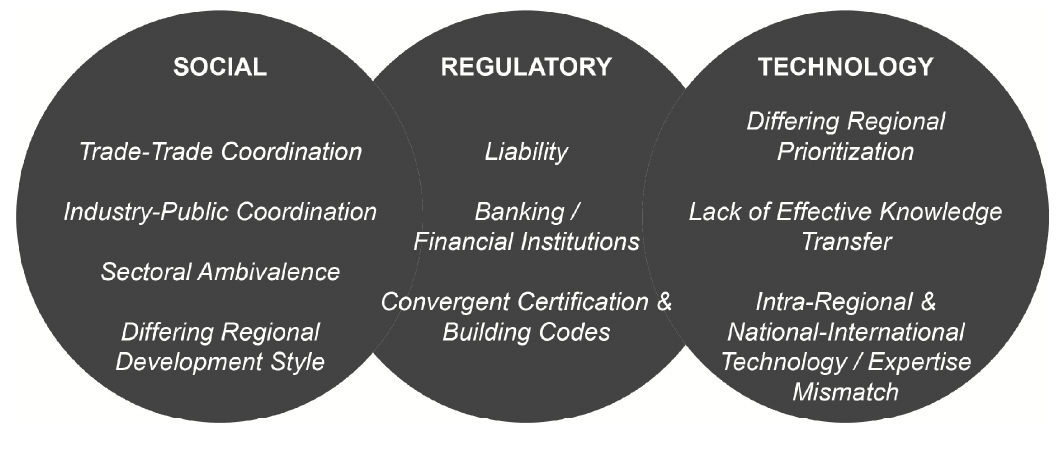
Figure 7. Reported challenge linked to technical aspects of sustainable